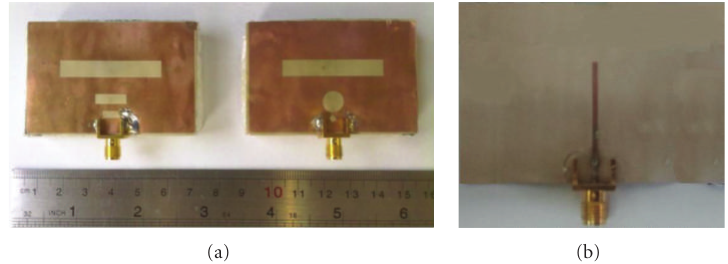
Figure 10: Photographs of the fabricated RDGS and CDGS wide slot antennas: (a) back and (b) front.